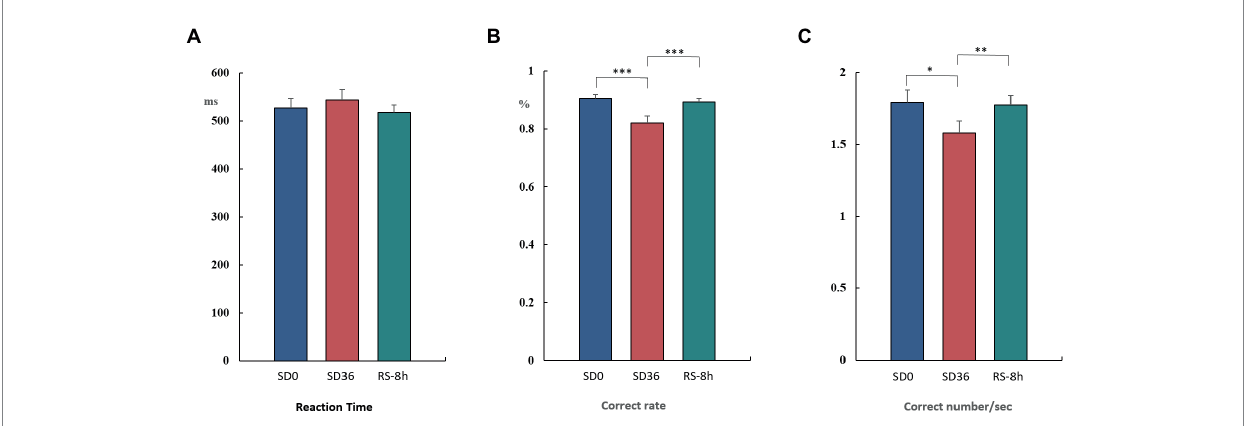
FIGURE 7 Reaction time, rate of correct responses, and number of correct responses per unit time in the three sleep states (mean ± standard deviation). SD: sleep deprivation; RS: recovery sleep. * p < 0.05, ** p < 0.01, *** p < 0.001.